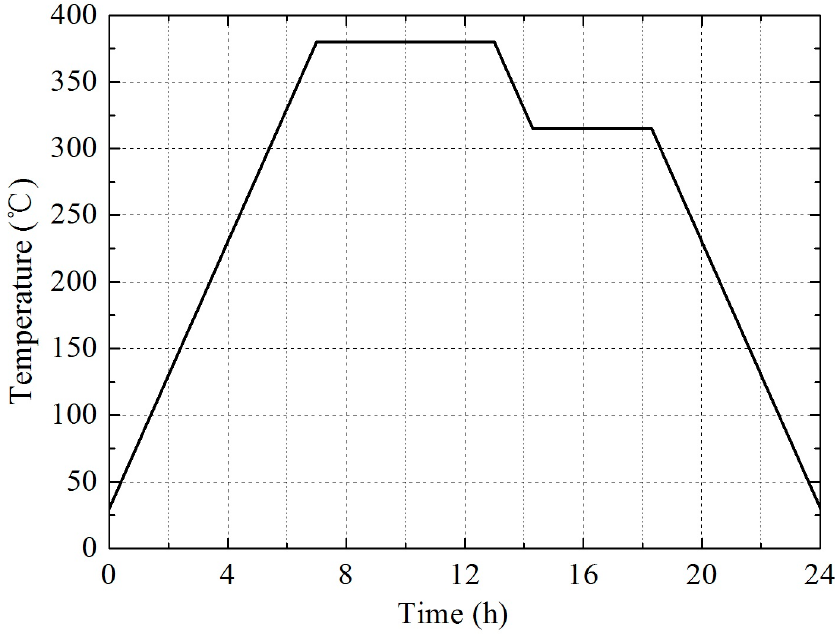
Figure 1. The temperature history of a sintering cycle.